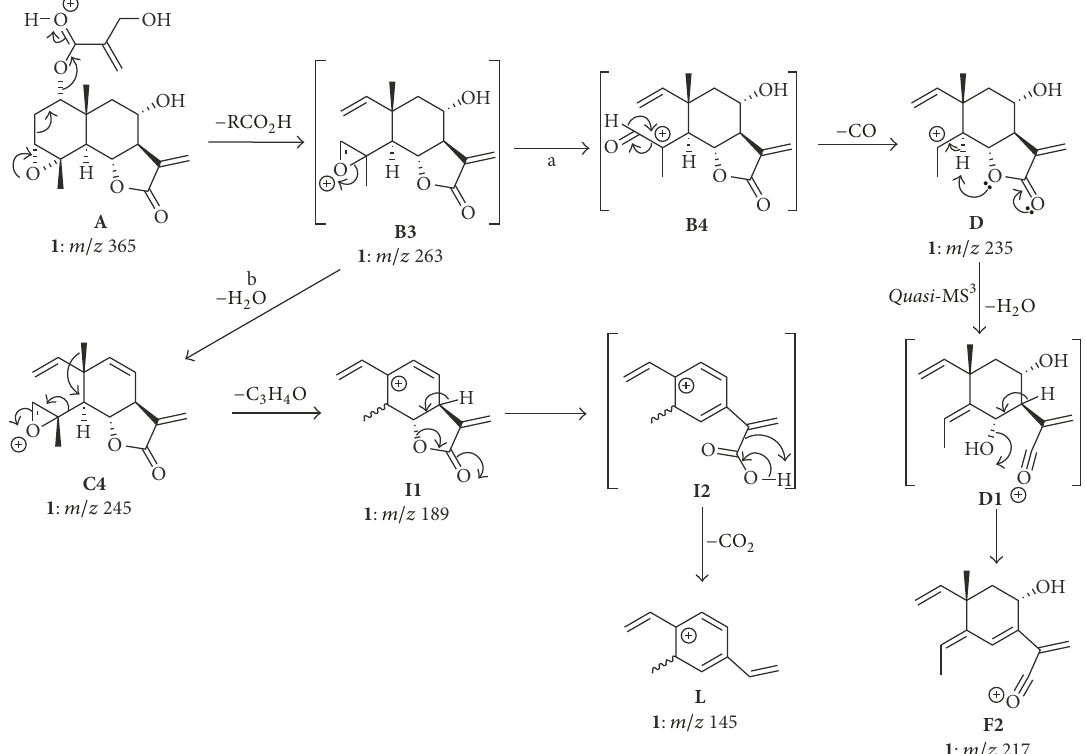
Scheme 4: Formation of diagnostic product ions D , I , and L for compound 1 .